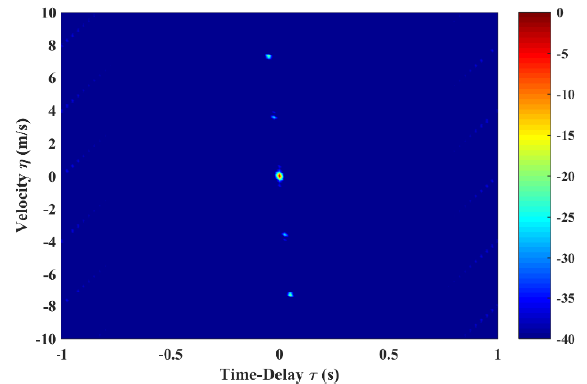
Figure 3. AF shapes of LFM-Costas pulse train after optimization. The optimized parameters are µ ∆ f t t = 391.994 Hz/s and t = 10.621 Hz. Other settings are the same as Figure 1b.